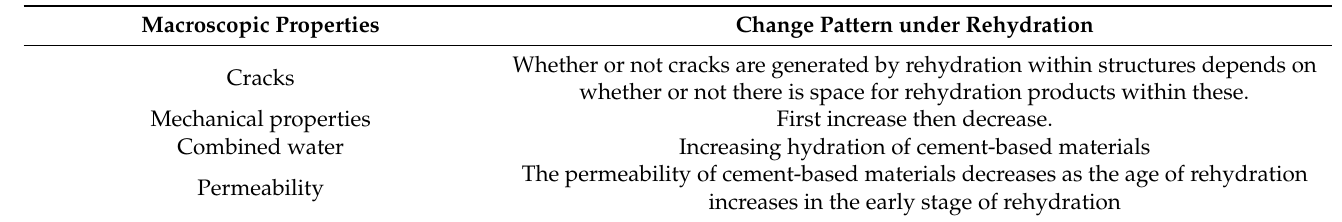
Table 2. Influence of rehydration on the macroscopic properties of cement-based